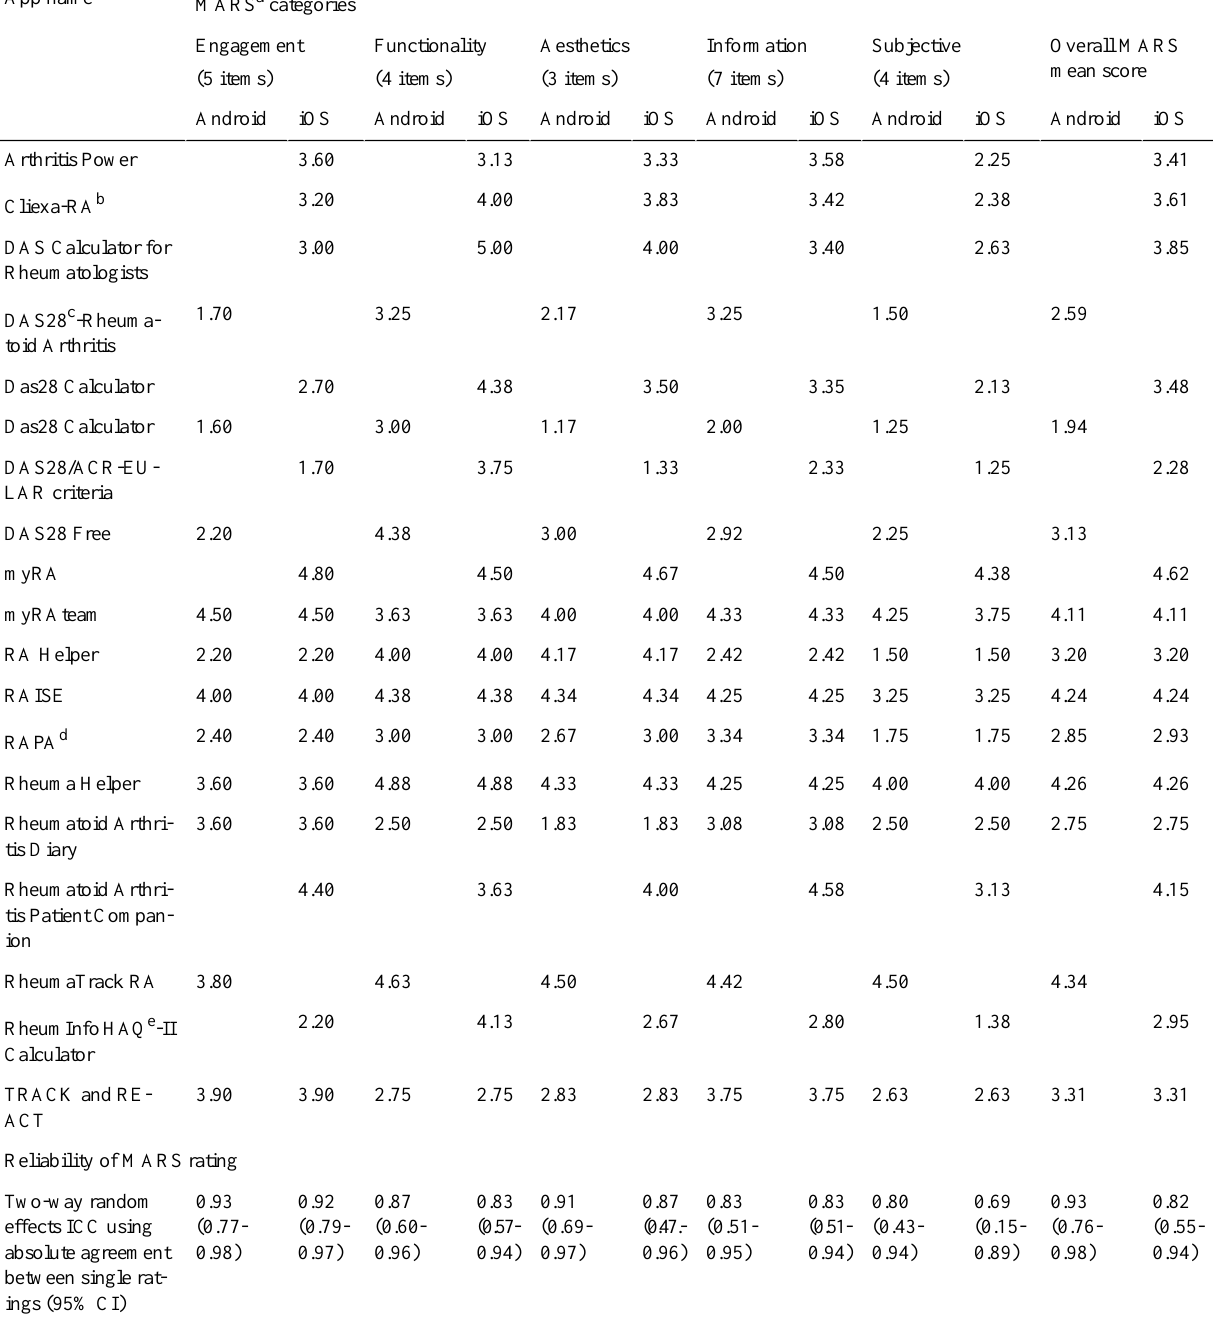
Table 6. Mean mobile app rating scale (MARS) ratings of included